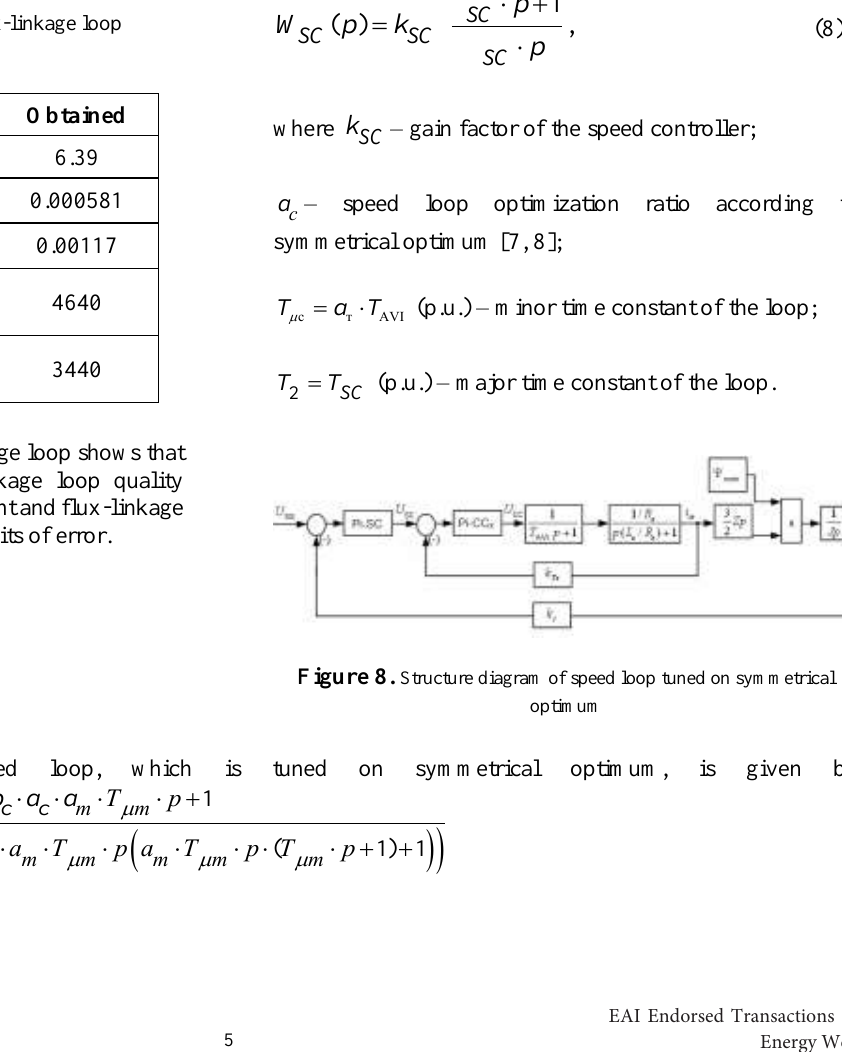
Table 2. Quality factors of closed flux-linkage loop